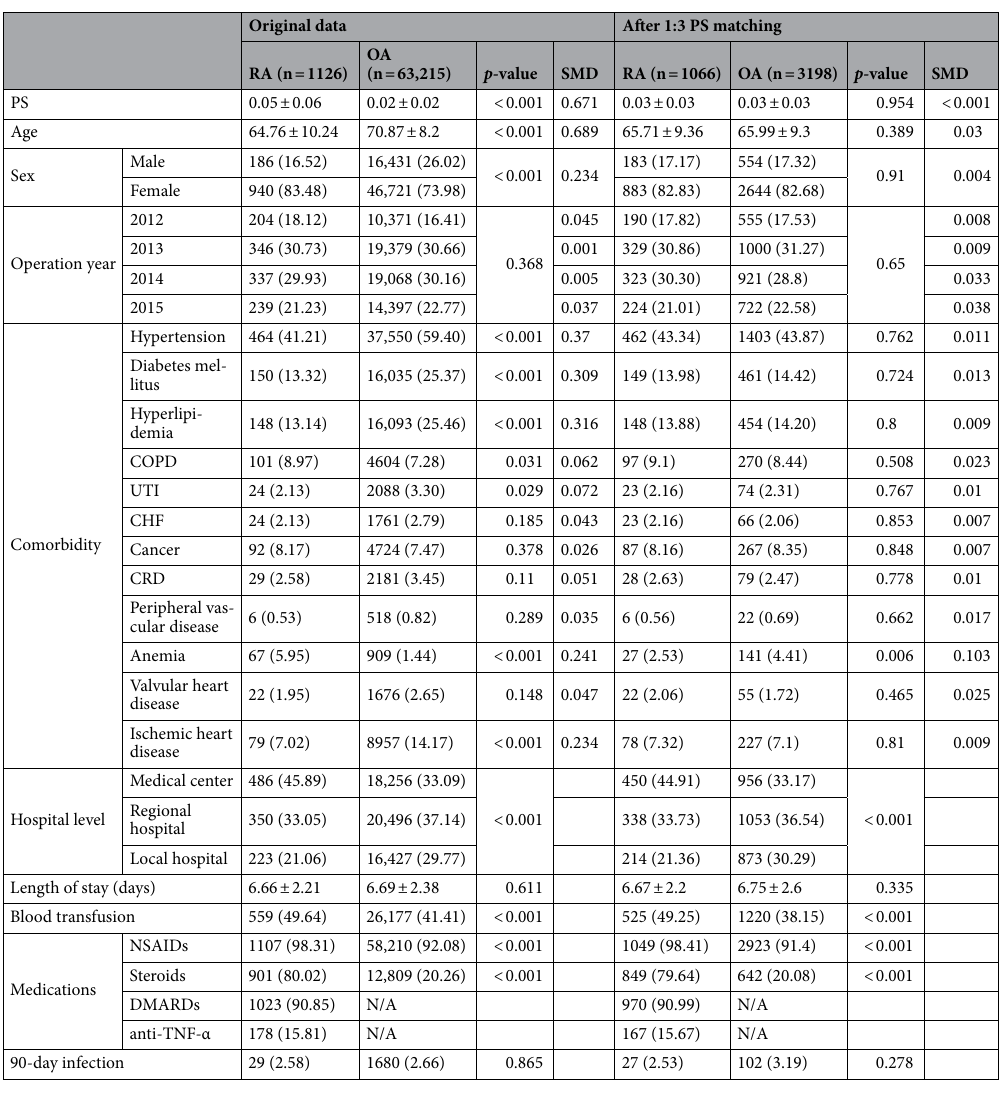
Table 1. Characteristics of the study population at baseline and 90-day follow-up after TKA. CI, confidence interval; CHF, congestive heart failure; COPD, chronic obstructive pulmonary disease; CRD, chronic renal disease; N/A, not applicable; NSAIDs, nonsteroidal anti-inflammatory drugs; OA, osteoarthritis; OR, odds ratio; PS, propensity score; RA, rheumatoid arthritis; SMD, standardized mean difference; UTI, urinary tract